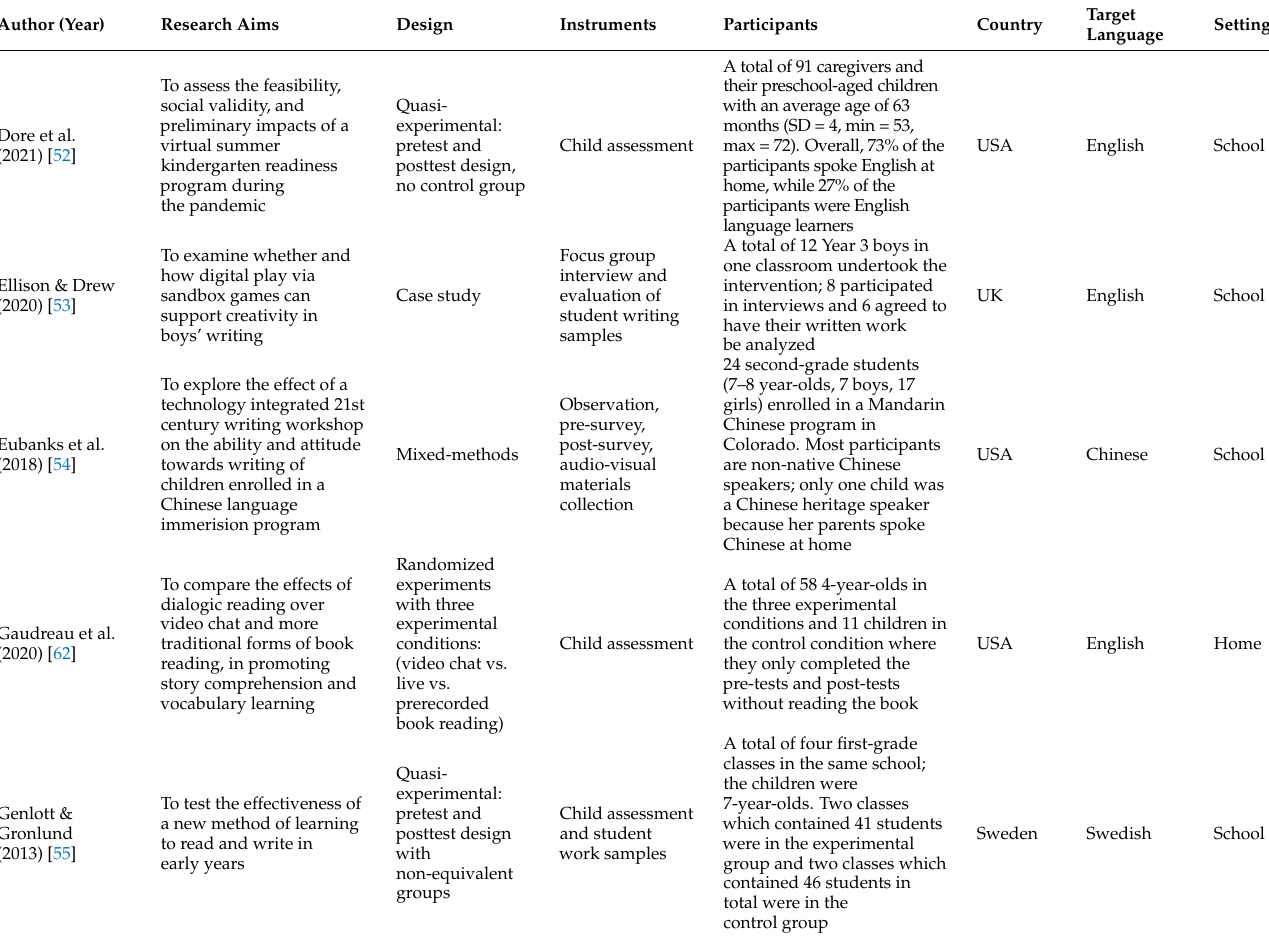
Table 2. Characteristics of included